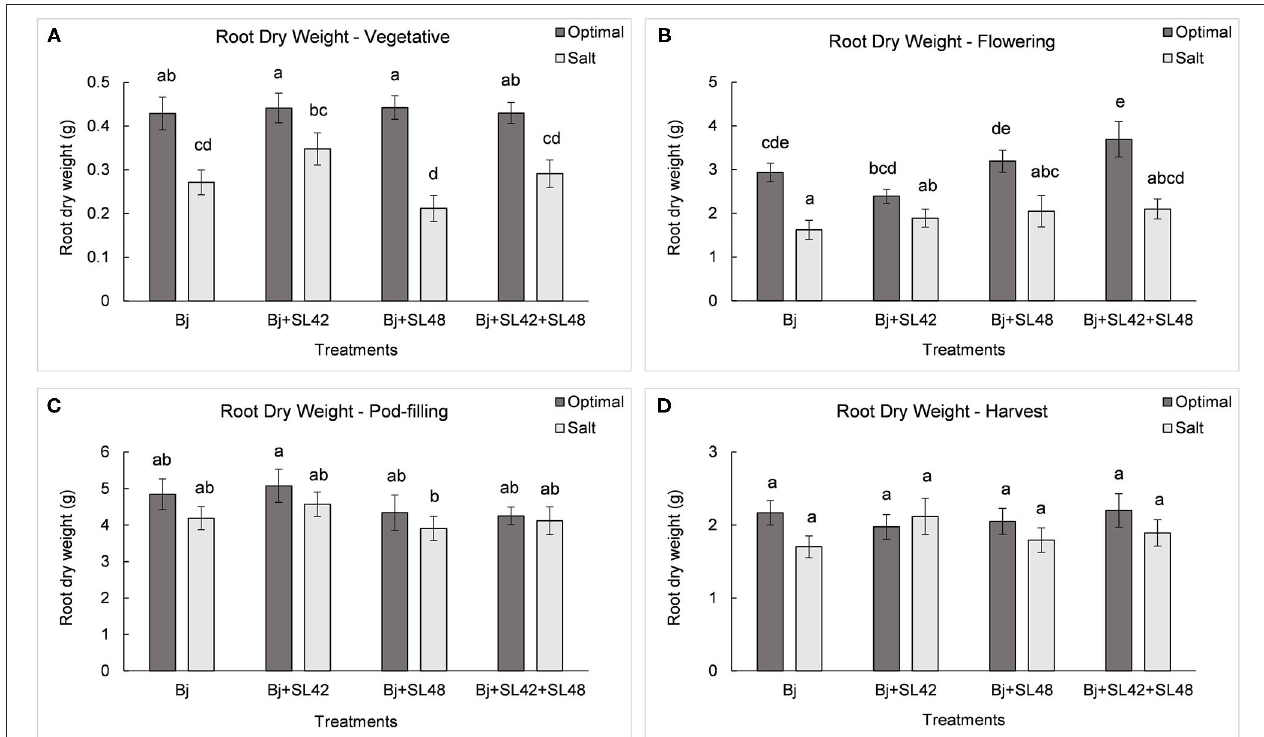
FIGURE 9 | Root dry weight of soybean plants measured at (A) mid-vegetative, (B) mid-flowering, (C) mid-pod-filling, and (D) harvest stages under optimal (water) and salt (150mM NaCl) conditions. The seeds were bacterized with Bradyrhizobium japonicum (Bj), Bj + SL42, Bj + SL48, and Bj + SL42 + SL48. Values represent mean ± SE ( n = 12). Scheffe grouping for least square means was used for multiple means comparison and means with the same letter(s) are not significantly different ( α = 0.05).